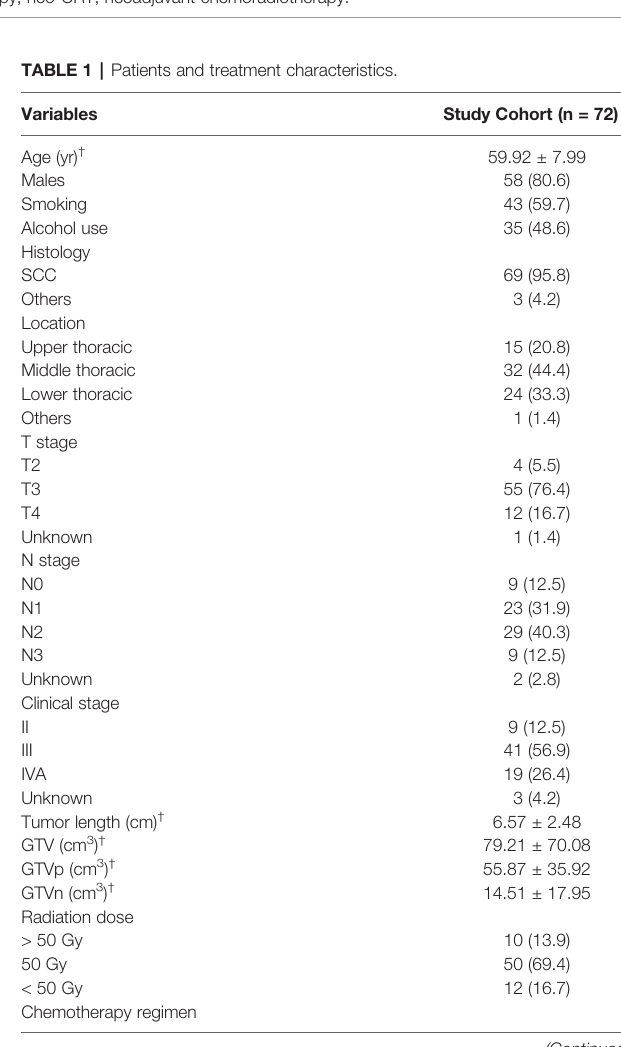
FIGURE 1 | Flowchart of patient inclusion. EC, esophageal cancer; RT, radiotherapy; neo-CRT, neoadjuvant chemoradiotherapy.